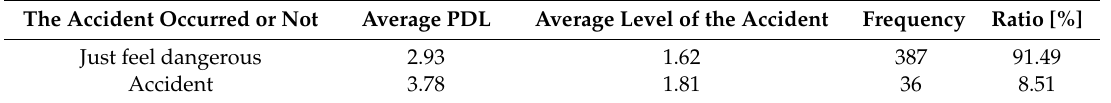
Table 4. Episode distributions relying on “the accident occurred or not”.